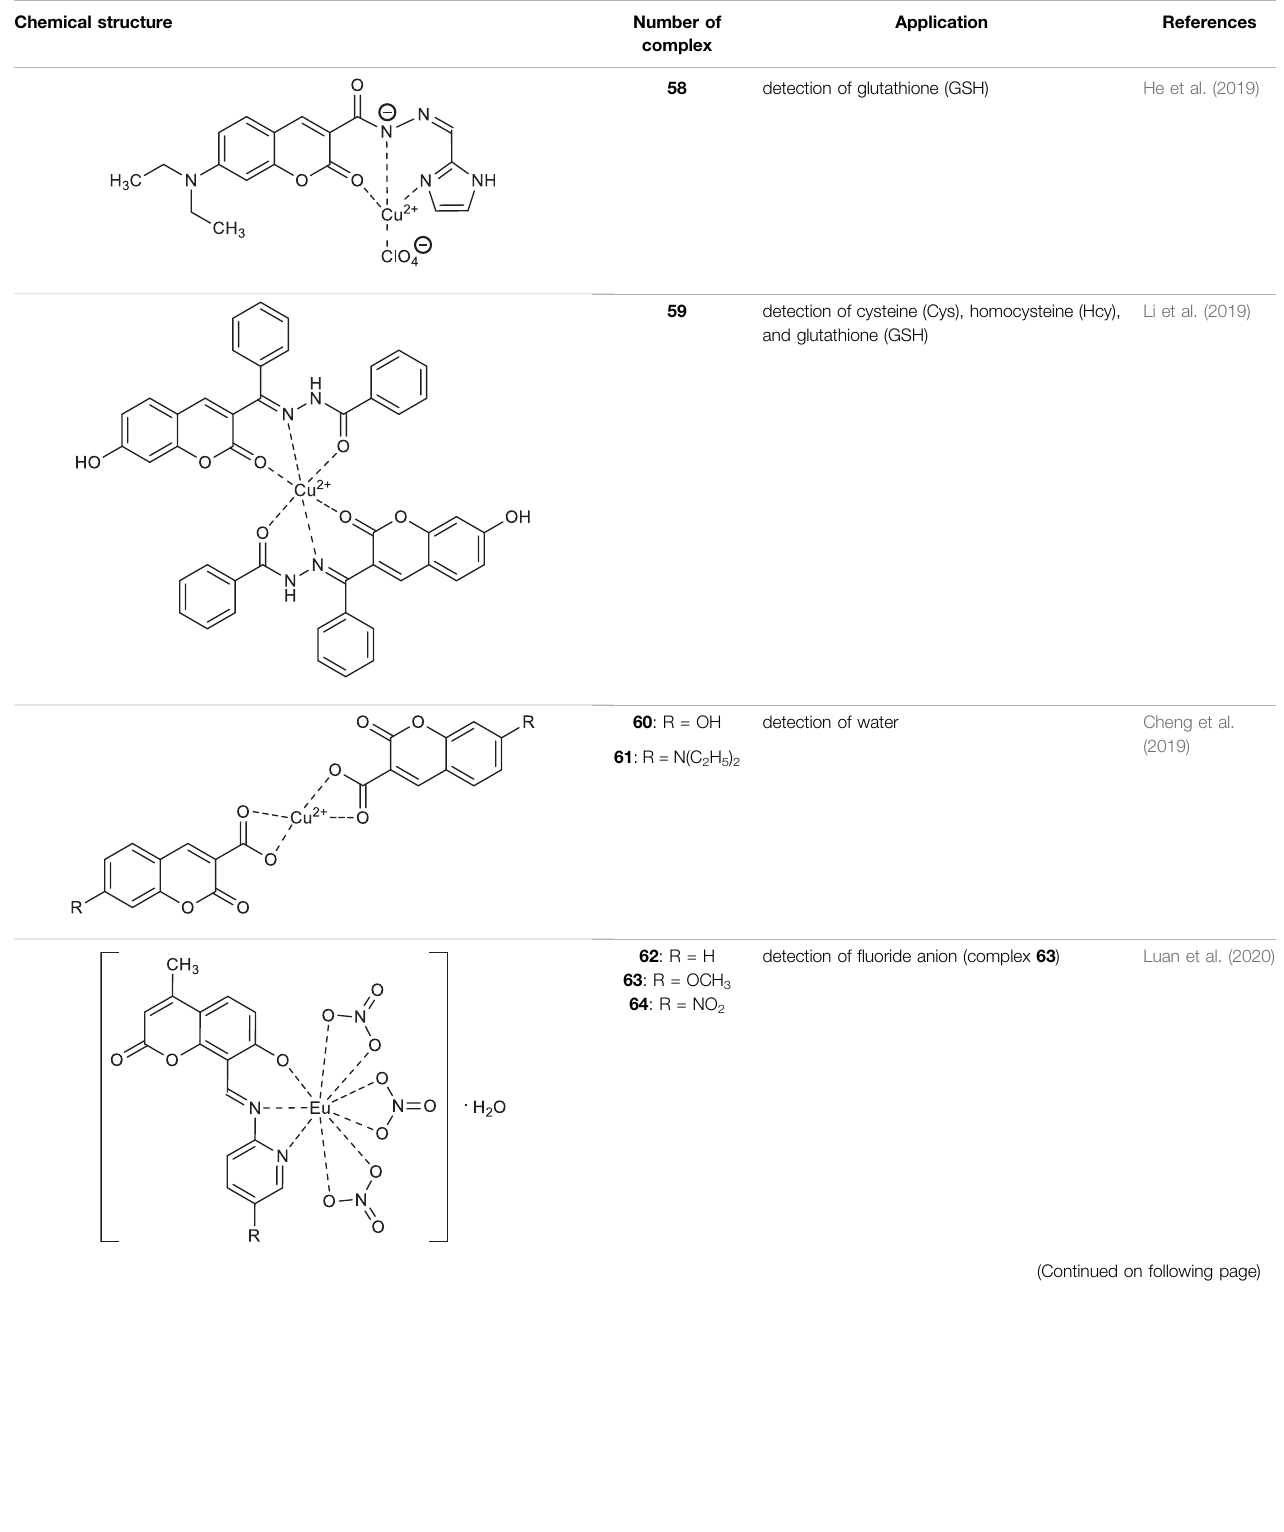
TABLE 2 | Coumarin-based metal complexes as fl uorescent